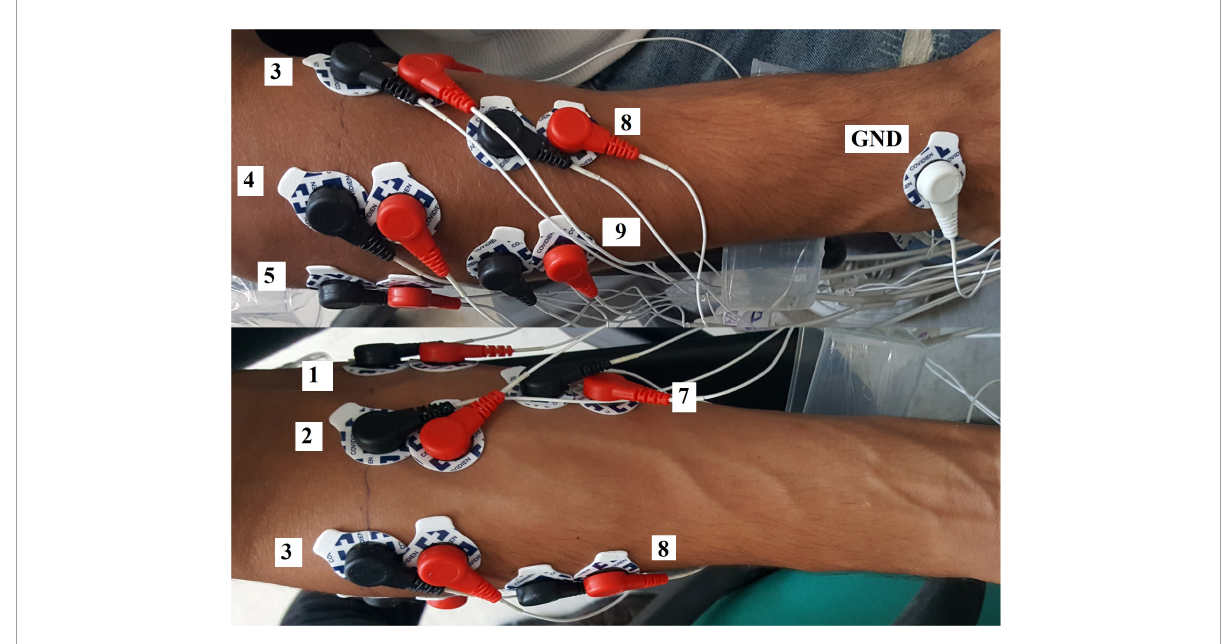
FIGURE1 Electrode placement on back (top of the picture) and front (bottom of the picture) of a right-handed subject in the Nearlab dataset. In total, 10 channels were used, 6 around the forearm, and 4 channels 3 cm distal to the previous ones. Electrodes 6 and 10 are not visible in this picture.